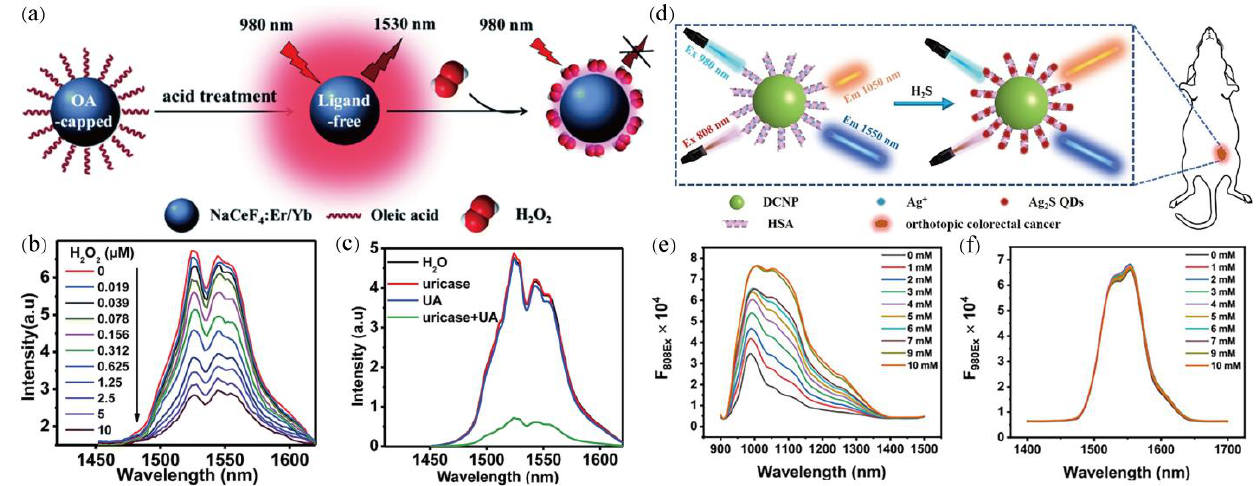
Figure 7. ( a ) Schematic of in sensing with NaCeF 4 : Er, Yb nanoprobes. ( b ) NIR−II spectra of NaCeF 4 : Er, Yb with different H 2 O 2 concentrations. ( c ) NIR−II spectra of NaCeF 4 : Er, Yb after the addition of H 2 O, uricase, UA, and uricase + UA, respectively. Adapted, with permission, from Ref. [86]. Copyright 2018, Royal Society of Chemistry. ( d ) Schematic diagram of the endogenous H 2 S−triggered in situ formation of Ag 2 S in the LnNCs@HSA−Ag + nanoprobe for the NIR−II. ( e , f ) NIR−II spectra of the nanoprobe under 808 nm and 980 nm, respectively. Adapted, with permission, from Ref. [87]. Copyright 2021, American Chemical Society.